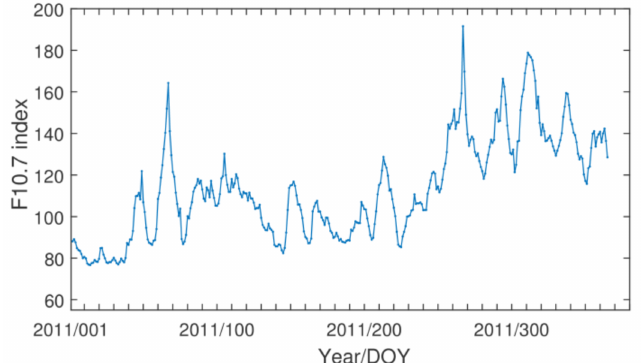
Figure 6. Time series of daily average values of the Solar 10.7 cm flux for